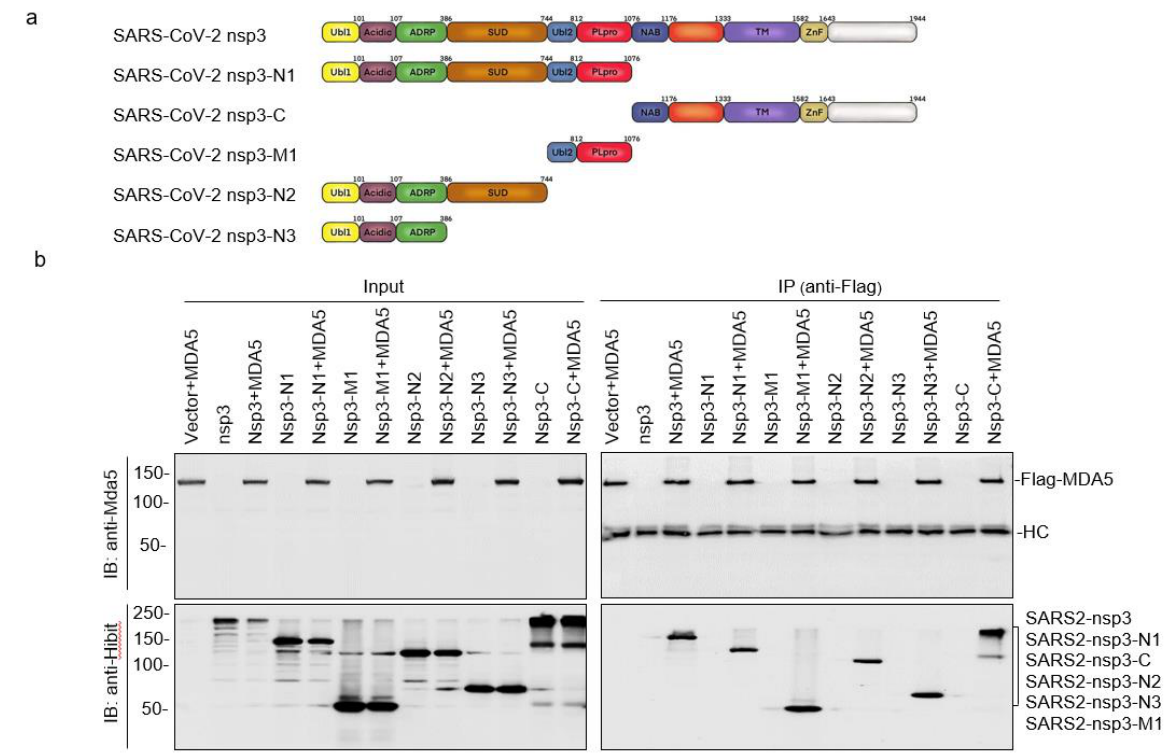
Figure 3. Mapping of the SARS-CoV-2 nsp3 domain(s) responsible for the interaction with MDA5. ( a ) Diagram showing the putative functional domains in the full-length and five truncated SARS-CoV-2 nsp3 constructs, nsp3-N1, nsp3-C, nsp3-M1, nsp3-N2, and nsp3-N3. ( b ) Co-immunoprecipitation of MDA5 with wild-type and truncated SARS-CoV-2 nsp3 constructs. HEK293T cells were transfected with wild-type and truncated SARS-CoV-2 nsp3 constructs, harvested at 24 h post-transfection, lysed with RIPA buffer, and subjected to immunoprecipitation with anti-Flag beads. Total cell lysates and precipitates were analyzed by Western blot with anti-Flag and anti-Hibit antibodies, respectively. Numbers on the left indicate protein sizes in